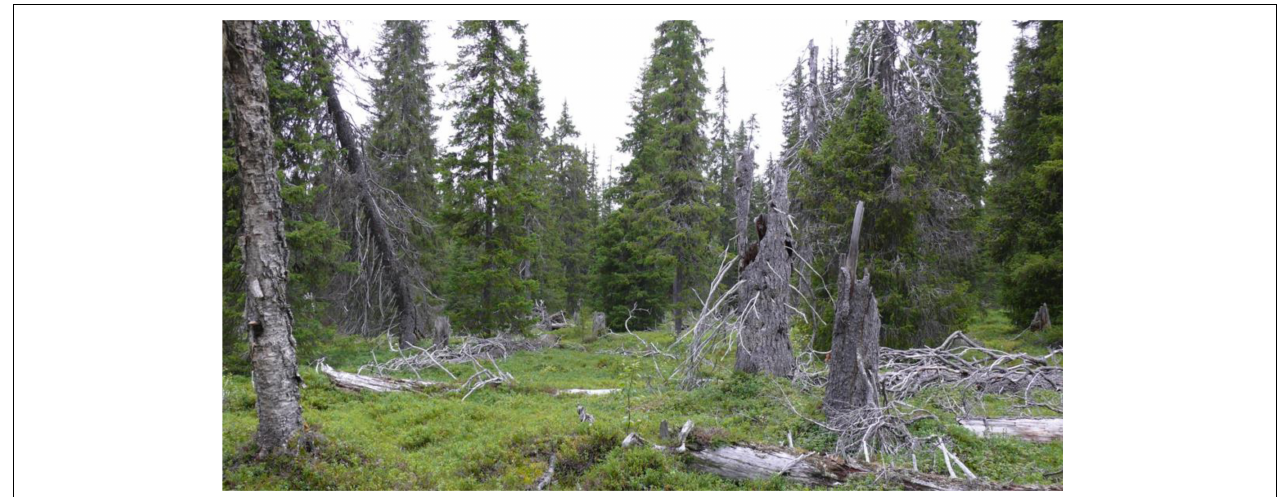
FIGURE 2 | A gap in the studied old-growth forest characterized by the narrow-crowned P. abies subspecies obovata and very variable, generally open canopy structure. Characteristic to the Hylocomium-Myrtillus type (HMT) forest (Cajander, 1926), the ground is covered by a thick layer of moss and small shrubs effectively inhibiting tree regeneration. Photograph: Timo